Question: Which kind of chart has been used to present this data?
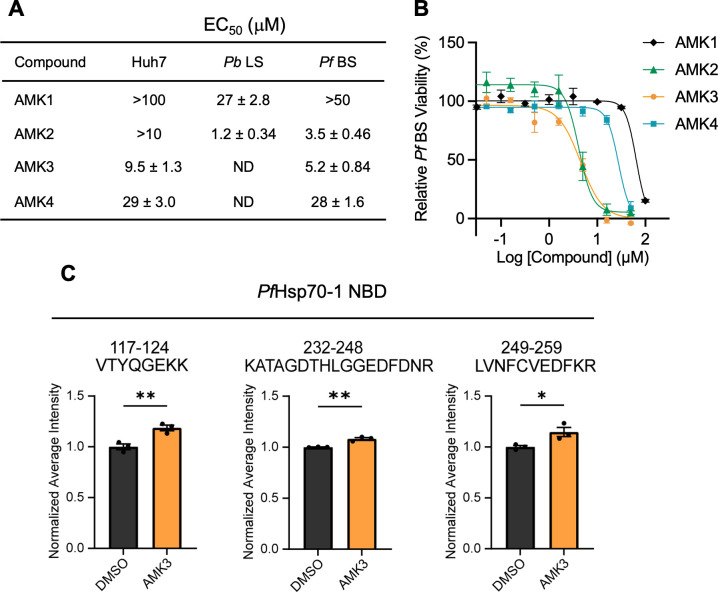
Answer: line